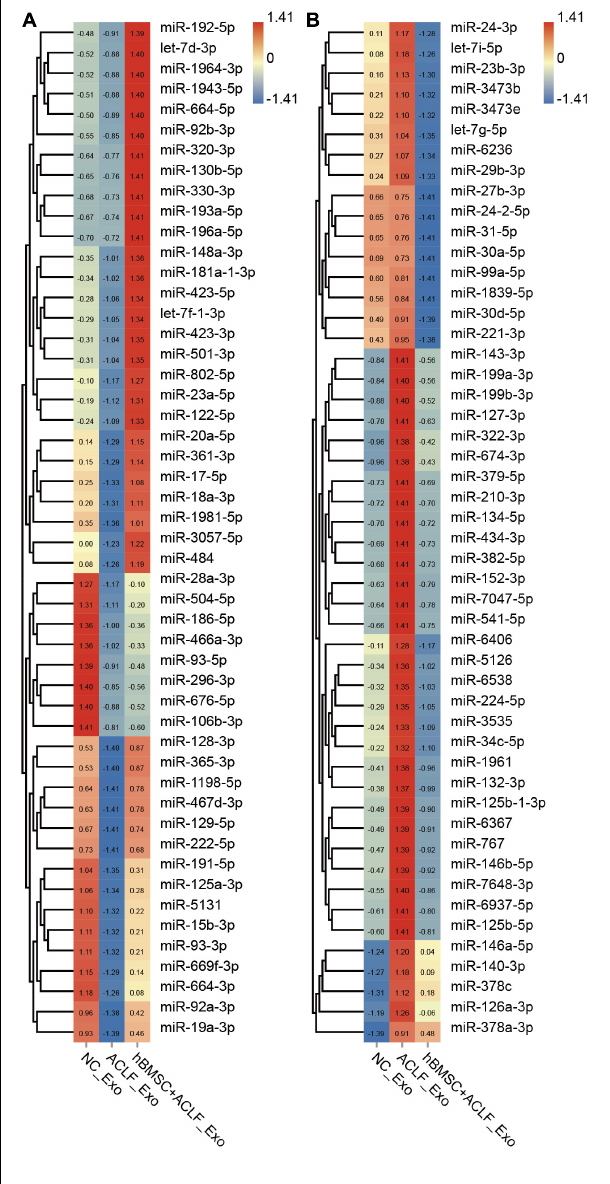
FIGURE 2 | Next-generation sequencing of exosomal miRNAs. The heat map shows the relative quantification of exosomal miRNAs; 50 down-regulated (A) and 50 up-regulated (B) miRNAs in ACLF hepatic exosomes. These changes are reversed upon co-culture with hBMSCs. Clustering was performed based on the expression trend. The Z value was used to normalize the RPM value. Red to blue refer to high to